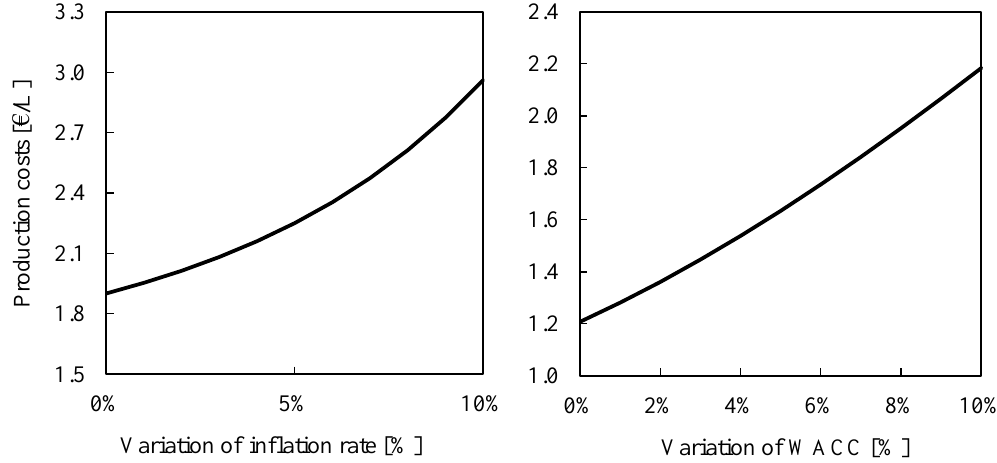
Figure A11. The sensitivity of production costs with respect to a change in the inflation rate ( left ) and weighted average costs of capital ( right ).